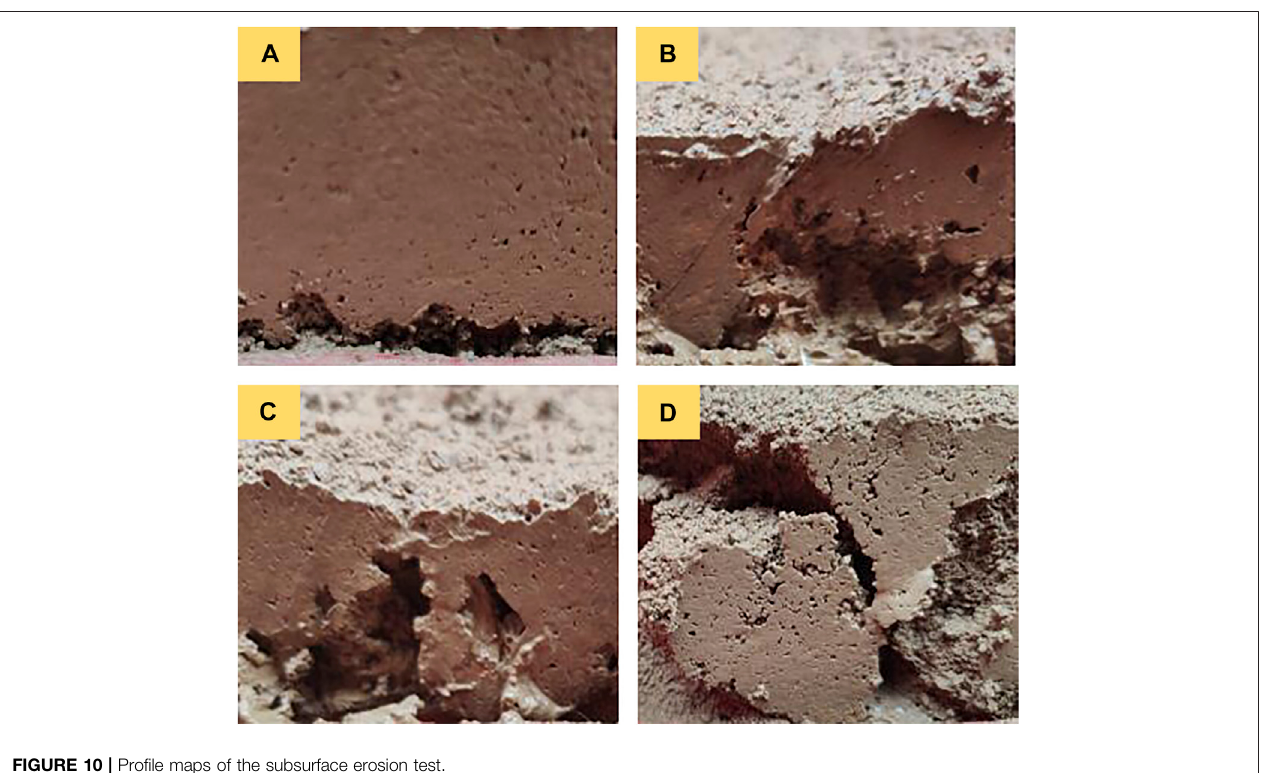
FIGURE 10 | Pro fi le maps of the subsurface erosion test.